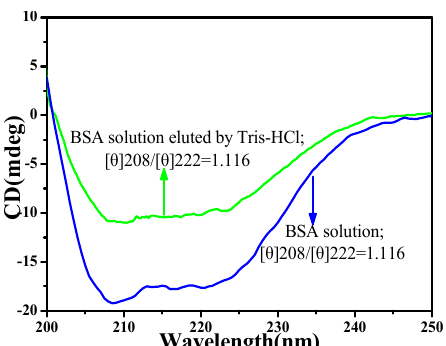
Figure 3. The circular dichromatic spectrum (CD) spectra of bovine serum albumin (BSA) and BSA aqueous solution eluted by Tris-HCl.